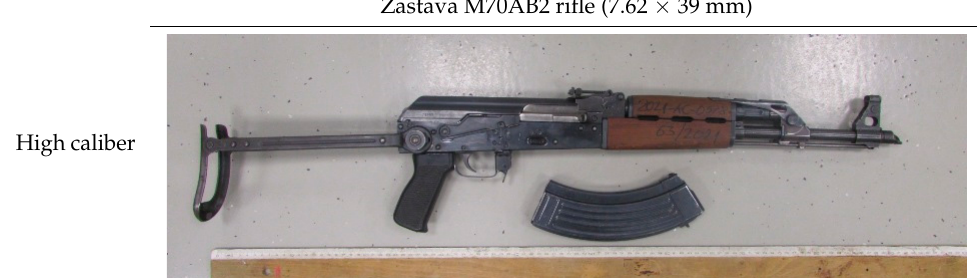
High High caliber High caliber